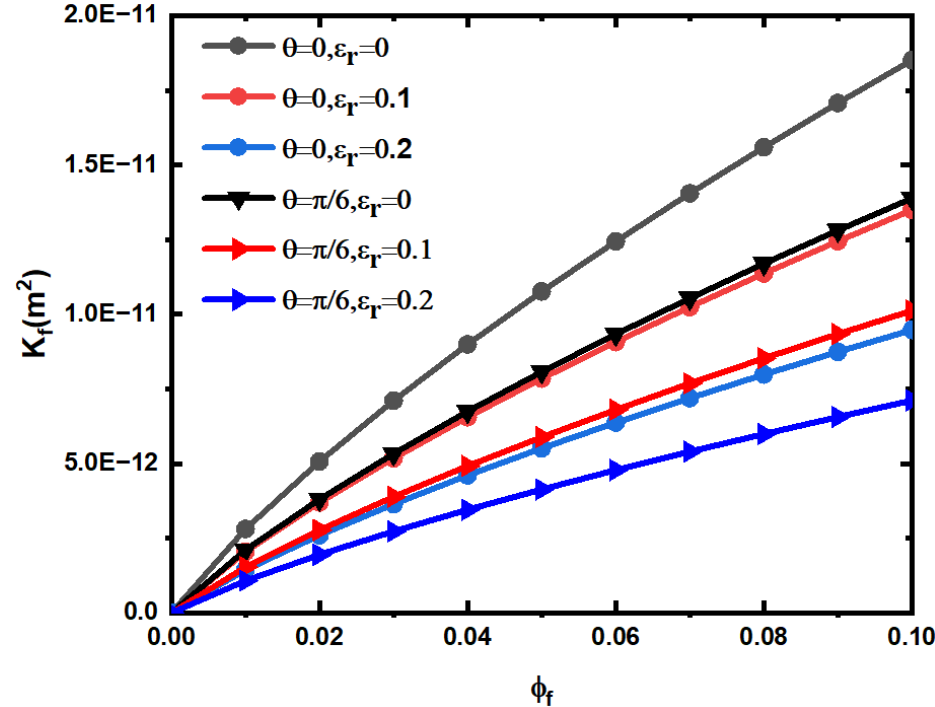
Figure 8. Permeability of the rough fracture network varies with fracture porosity under different inclination and relative roughness.